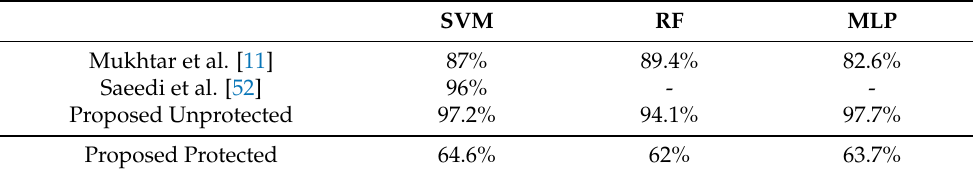
Table 3. Maximum Accuracy comparison between